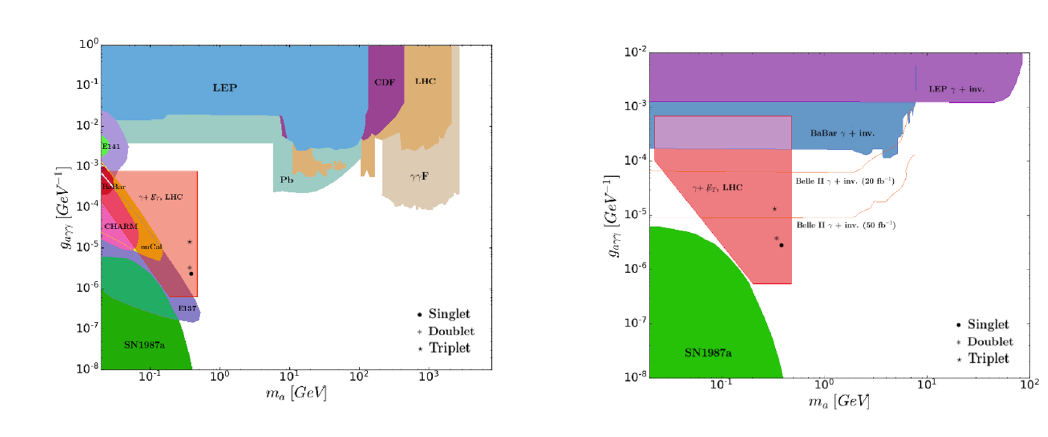
Figure 11 . Comparison of the (cid:13) + =E search of this work, the red shaded area, at 95% CL, against T several experiments searching for ALPs coupling to photons [11, 13, 14, 16, 20, 30, 62, 73{75]. The limits at the left panel are taken from refs. [22] and [15]. The prospects of the collider experiments will shrink with the addition of the sterile neutrino decay channel but the LHC one obtained in this work. The green shaded area represents the constraints from supernova data. The points represent benchmarks of the model presented in section 5. Comparison of the LHC against LEP, Belle and BaBar prospects [30] to probe the ALP-photon coupling are shown at the right panel where we also added the SN 1987 limit from ref. [22].